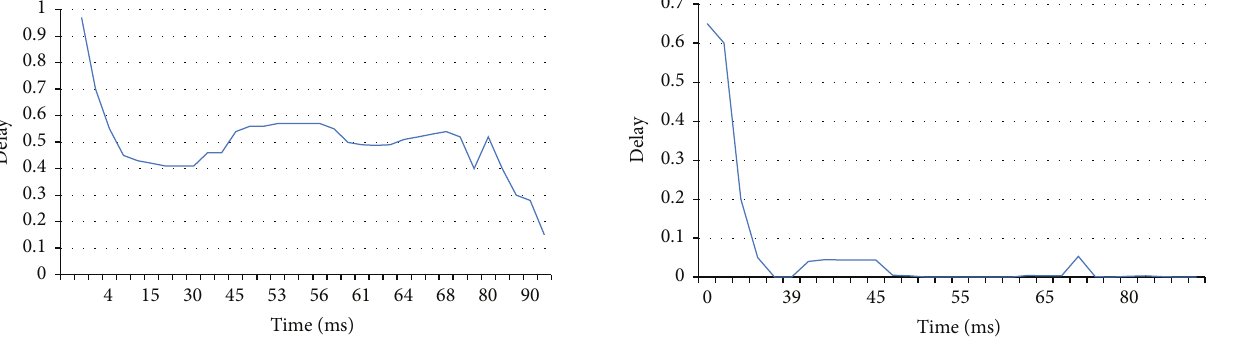
Figure 6: System delay for 8 legitimate nodes and 2 jammers.